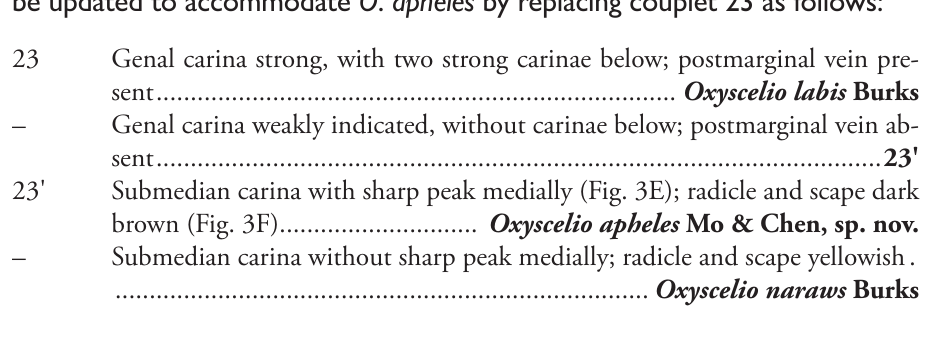
Figure 4 Description. Female. Body length 2.9–2.93 mm (n = 2). Radicle color: same color as scape. Scape color: yellowish. A4: broader than long. A5: broader than long. Antennal club in female: formed, segments compact. Interantennal process: not elongate. Median longitudinal elevation in frontal de- pression: absent. Frontal depression: concave. Frontal depression sculpture: with 3 broadly interrupted transverse carinae below submedian carina. Submedian carina: strong, formed by a sharp raised carina. Submedian carina medially: without peak. Concavity across dorsal part of frontal depression: absent. Depression extending ven- trally from median ocellus: absent. Upper frons: hood-like. Malar area near antennal foramen: without carina or expansion. Facial striae: present. Smooth strip along poste- rior side of malar sulcus: absent or not consistently broad. Genal carina: present. Direc- tion of genal carina dorsally: parallel to eye margin. Major sculpture of gena anteriorly: rugose; foveate. Major sculpture of gena posteriorly: rugose; foveate. Microsculpture of gena anteroventrally: absent. Microsculpture of gena posteroventrally: absent. Me- dian carina extending posteriorly from hyperoccipital carina: present. Hyperoccipital carina: complete, extending ventrally around outer orbit of compound eye. Lateral connection between hyperoccipital and occipital carinae: absent. Area between vertex and occipital carina: irregularly rugose. Occipital carina medially: uniformly rounded. Lateral corners of occipital carina: not protruding. Lateral pronotal area: without bulge projecting towards anterior pit. Transverse pronotal carina: present anteriorly and forming a corner with epomial carina.